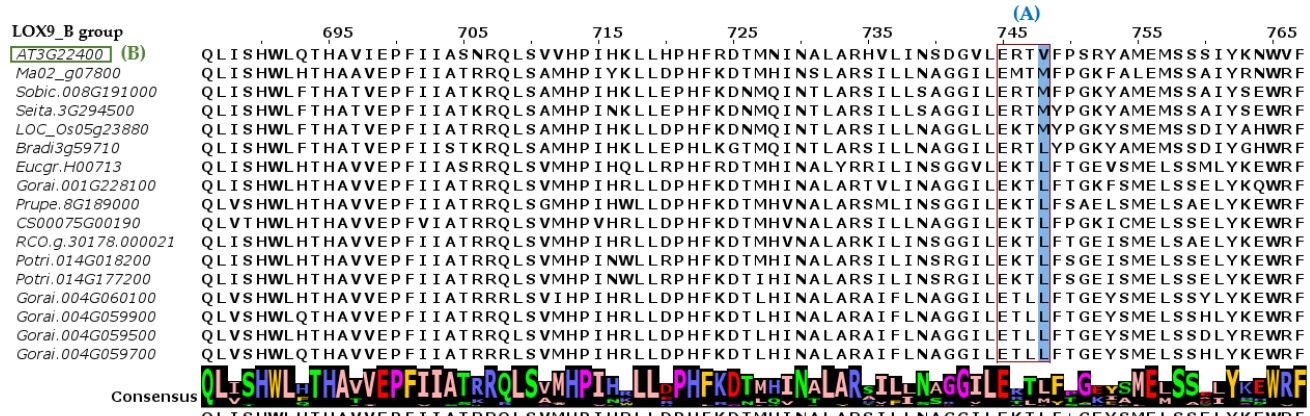
Figure 3. LOX9_B group and its pattern of amino acid conservation in motif sequences ( A ). This subclade had a specific conservation site for amino acids leucine (L) or methionine (M) (blue column). Diverging from the conservation pattern of LOX9 proteins in angiosperm species, including Arabidopsis thaliana , represented by AT3G22400 ( B ), a LOX9 gene, which had, in the same place (blue column), the amino acid valine (V), was conserved. We used MAFFT software version 7 for alignment and JALview for visualization.